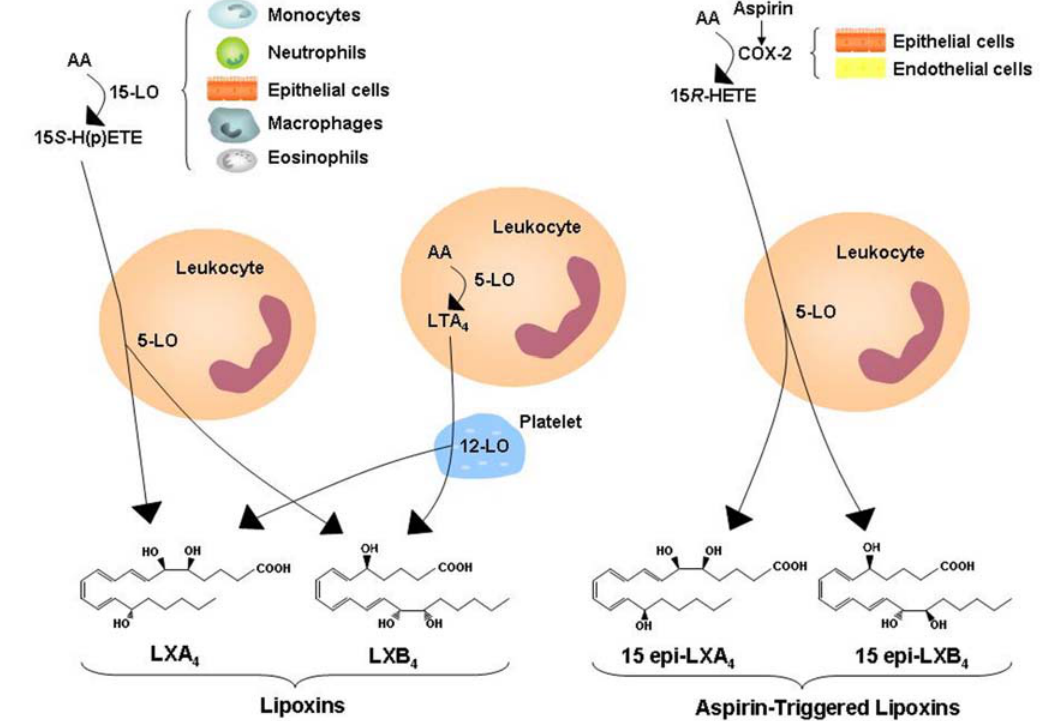
FIGURE 2. Biosynthesis of LXs and ATLs. During cell-cell interaction, LXs can be generated by transcellular biosynthesis via interaction of two or more cells. Two main classic LX-generating pathways involve the interaction of